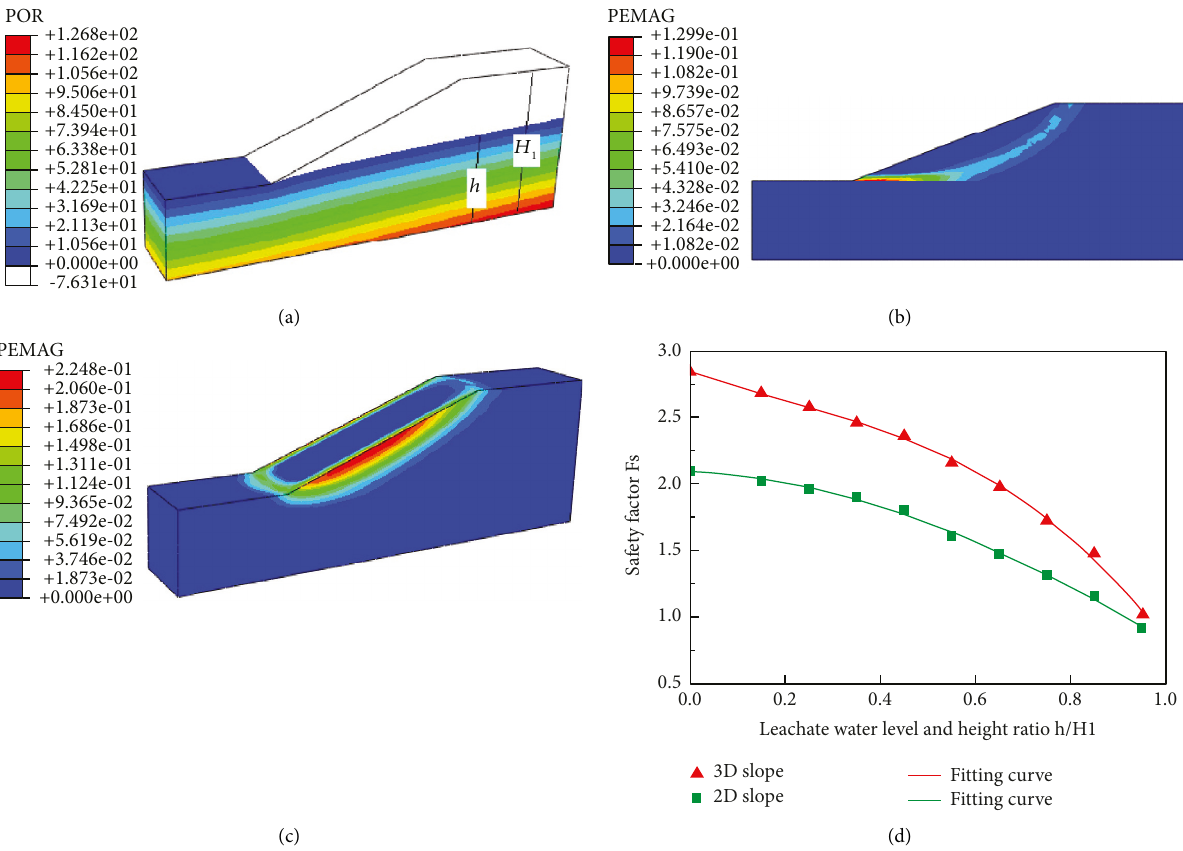
Figure 14: (a) The leachate level and distribution of pore pressure (POR) (kPa). (b) The plastic zone of the two-dimension slope of critical buckling destruction when h / H 1 � 0.65 (safety factor is 1.471). (c) The plastic zone of the three-dimensional slope of critical buckling destruction when h / H 1 � 0.65 (safety factor is 1.982). (d) The relation curve between safety factor and leachate level-height